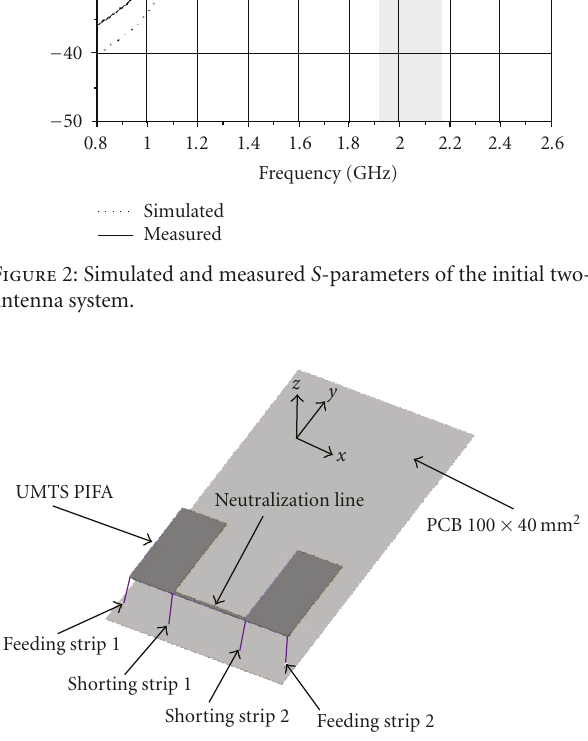
Figure 3: 3D view of the two-antenna system with a suspended line between the PIFA shorting